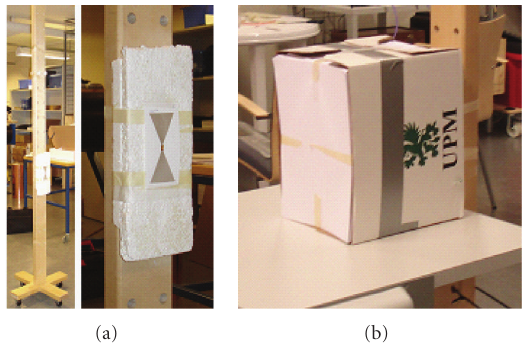
Figure 4: The measurement arrangements: (a) the tag fastened to a holder; and (b) the tag behind paper reams.